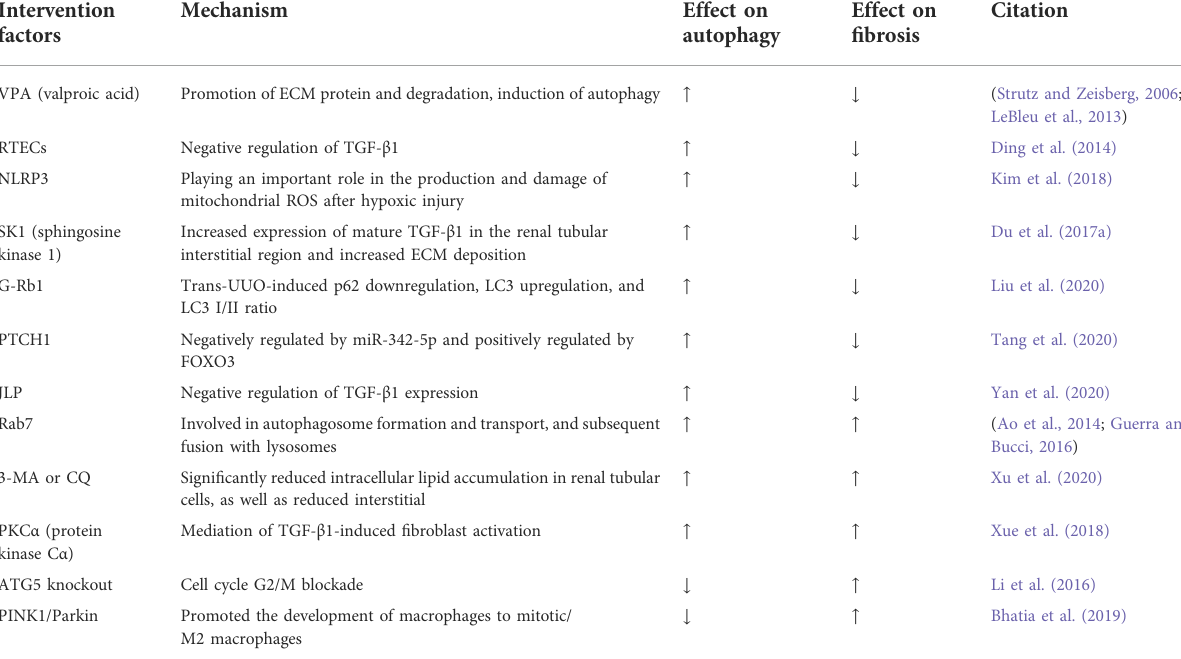
TABLE 2 Dual regulation of autophagy in unilateral ureteral obstruction